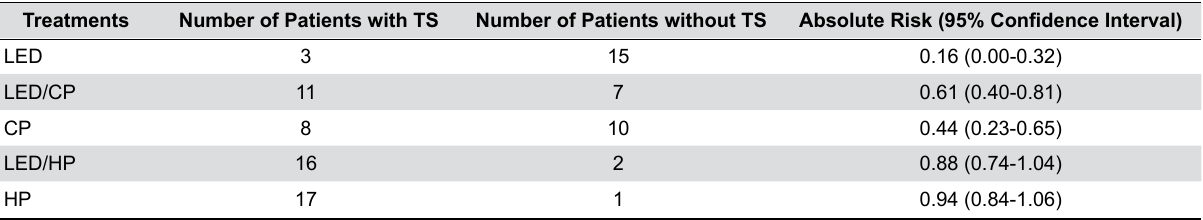
Table 3- Number of patients with and without tooth sensitivity (TS) and risk of TS of each bleaching protocol with corresponding 95% confidence